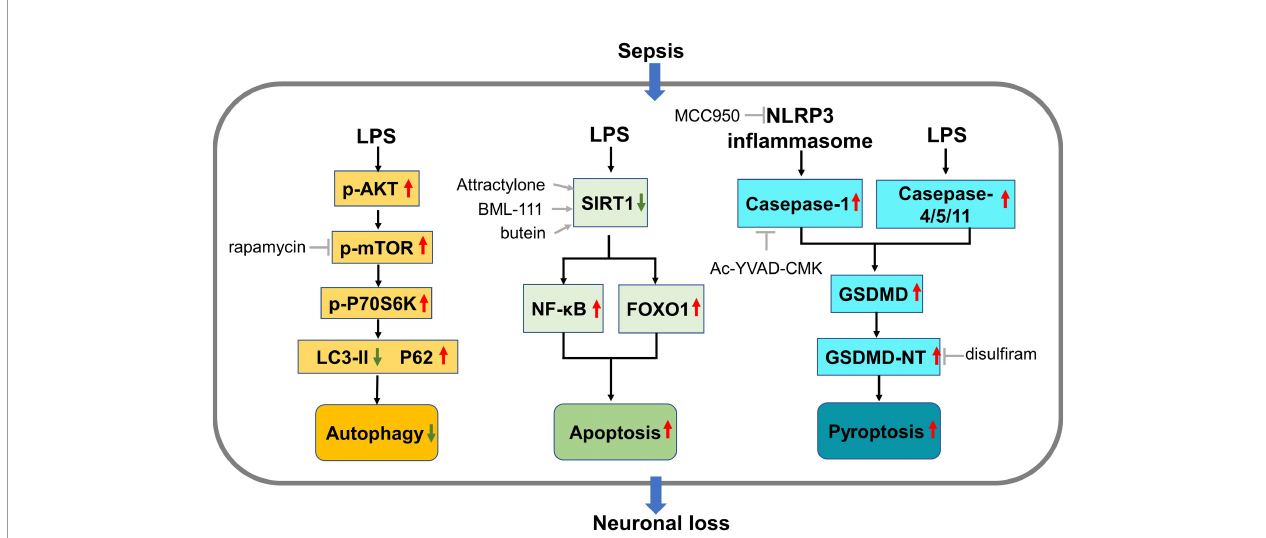
FIGURE 2 | Mechanisms of neuronal loss in sepsis. During sepsis, the AKT/mTOR pathway is activated and inhibits the normal autophagy process in neurons, leading to autophagic neuronal death. Suppression of SIRT1 by LPS activates NF- k B and FOXO1, triggering neuron apoptosis. In fl ammasome generated in sepsis activates casepase-1 while LPS activates casepase-4/5/11, both of which promotes the generation of GSDMD. Cleavage of GSDMD produces GSDMD-NT which forms membrane pores and lead to neuronal pyroptosis. LPS, lipopolysaccharides; mTOR, mammalian/mechanistic target of rapamycin; LC3, SIRT1, silent information regulator 1; FOXO1, forkhead box protein O1; GSDMD, gasdermin D; GSDMD-NT, GSDMD-N-terminal